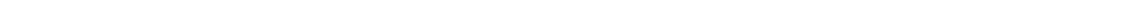
Fig. 1 Characterization of cytoplasmic inclusions in BSR cells infected by RABV. BSR cells were infected with CVS strain at a MOI of 0.5 and fi xed at different times p.i. (8 h, 12 h, 16 h, 24 h). a Confocal analysis was performed after staining with a mouse monoclonal anti-N antibody followed by incubation with Alexa-488 donkey anti-mouse IgG. DAPI was used to stain the nuclei. Scale bars correspond to 15 µ m. b – d Quanti fi cation of cytoplasmic structures labeled with anti-N antibody. At the indicated time p.i. the number of small dots (surface < 0.26 µ m 2 ) b , of intermediate inclusions (surface between 0.26 and 3.7 µ m 2 ) c , and of large inclusions (surface > 3.7 µ m 2 ) d per cell was quanti fi ed using the image toolbox of MatLab software as described in the experimental procedures. * p < 0.02; ** p < 0.01 ( n = 20, two tailed Mann Whitney U test). e Average surface of the largest inclusion in the cell at the indicated time p.i. Surfaces of inclusions were determined using the image toolbox of MatLab software as described in the experimental procedures. The mean is shown with error bars representing the SD. *** p < 10 − 4 ( n = 20, two tailed Welch ’ s t -test). f Confocal analysis revealing the basal localization of small dots and the median localization of inclusions in RABV infected cells at 24 h p.i. The analysis was performed after staining as in a . Scale bars correspond to 15 µ m. g , h EM characterization of the ultrastructural aspects of BSR cells infected by RABV. Basal sections g reveal the presence of RNPs whereas median sections h reveal the presence of NBs displaying an electron dense granular structure (colored in blue in the bottom row) which lose their spherical shape when they associate with membranes at 24 h